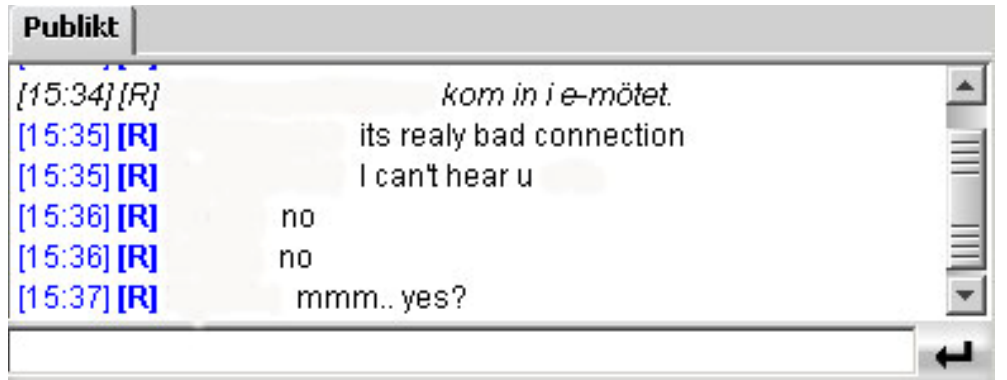
Figure 5 . Connectivity problems can interfere with sound (names removed from